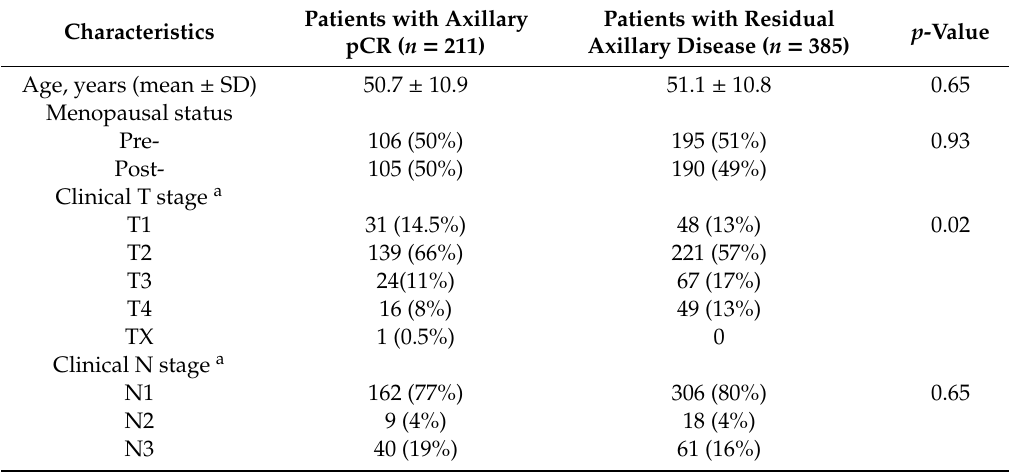
Table 1. Clinicopathological characteristics of patients after neoadjuvant chemotherapy